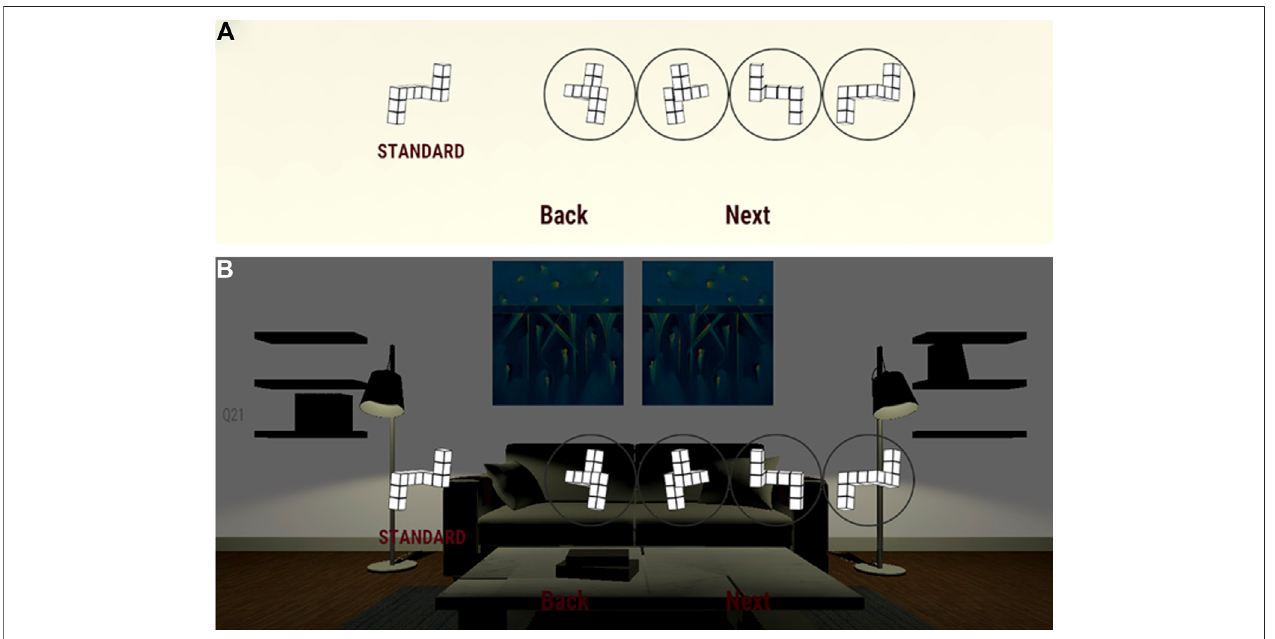
FIGURE 2 | Two unique VEs were developed for the IMRT: (A) a simple, off-white space devoid of visual cues (Test 1); (B) a more complex virtual room providing several visual cues (Test 2). Both Test 1 and Test 2 (simple vs complex backgrounds) are conducted in Room A and Room B (2D vs 3D stimuli) shown in Figure 1 .